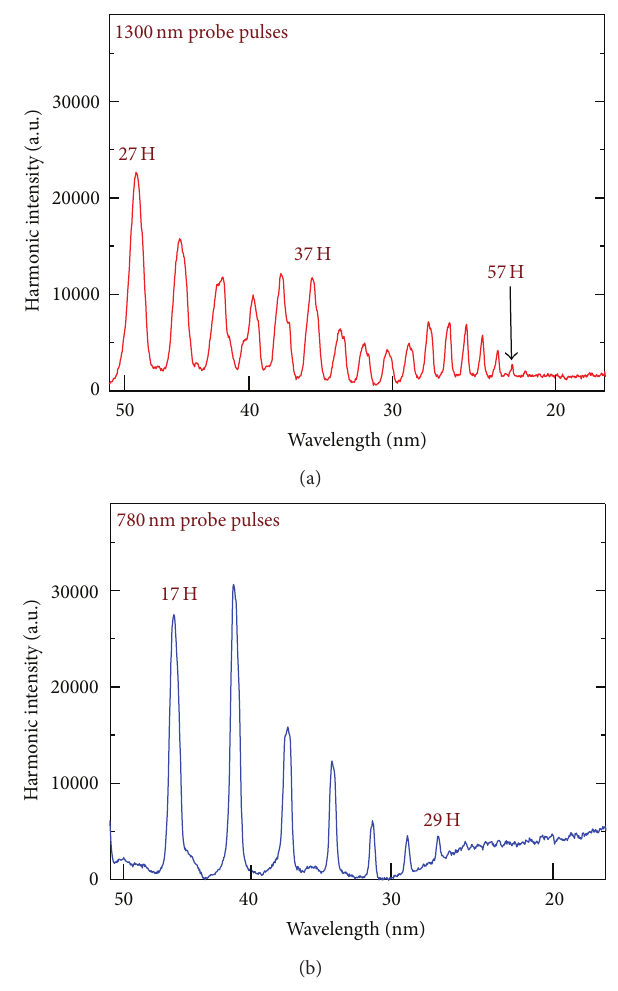
Figure 10: Carbon plasma harmonic spectra using the 1300nm (a) and 780 nm (b) probe pulses. The energies of probe pulses were 0.2 mJ (a) and 0.54 mJ (b). Ablation was carried out using 20 ps, 780 nm, and 1kHz laser pulses